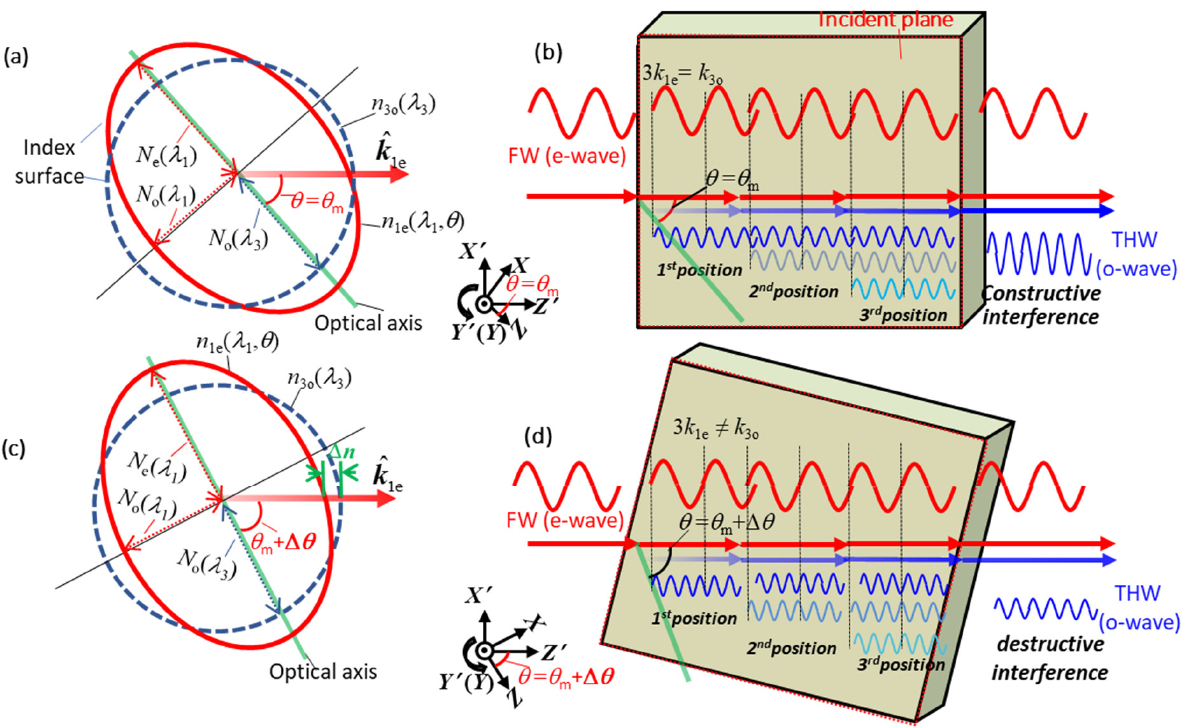
Figure 2. ( a ) The refractive index surface of type I phase-matching case; ( b ) The type I phase-matching process in a crystal; ( c ) The refractive index surface of type I phase-mismatching case; ( d ) The type I phase-mismatching process in crystal.